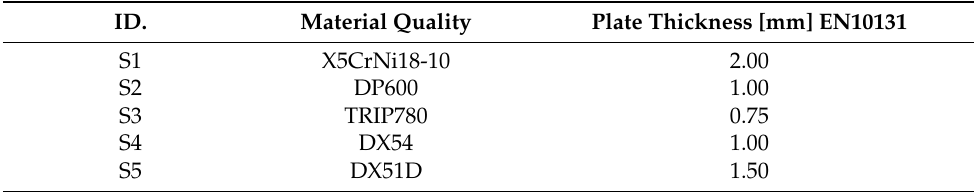
Table 3. Steel sheet materials used for painting tests.